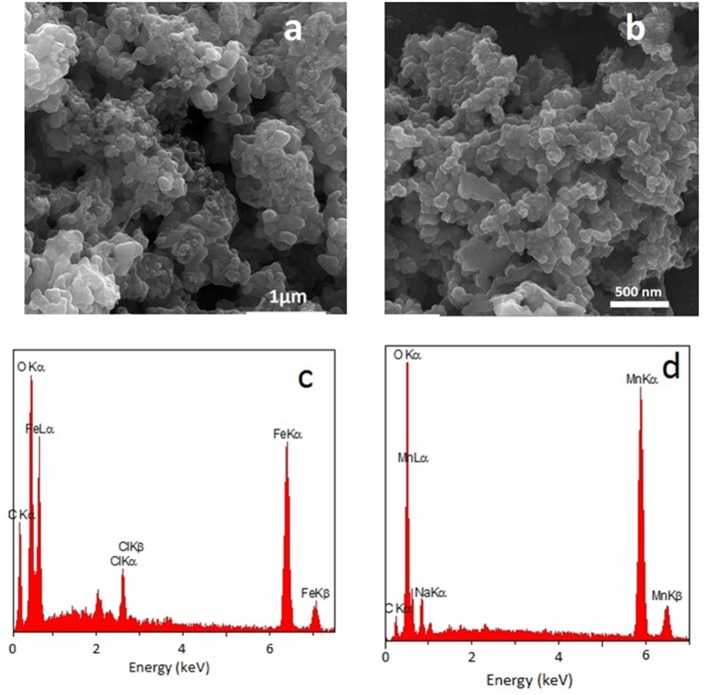
FESEM image and EDS spectrum of FeOx-CB containing 30 wt.% total carbon annealed at 300°C (a,c) and FESEM image and EDS spectrum of Mn3O4
(b,d).